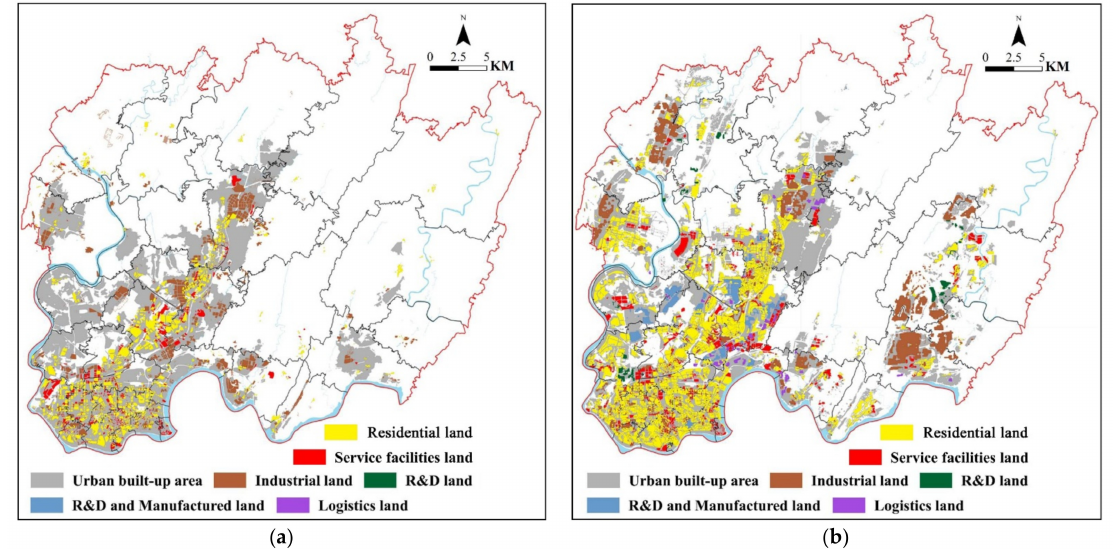
Figure 4. ( a ) Construction land of LNNA in 2010; ( b ) construction land of LNNA in 2015 (source: